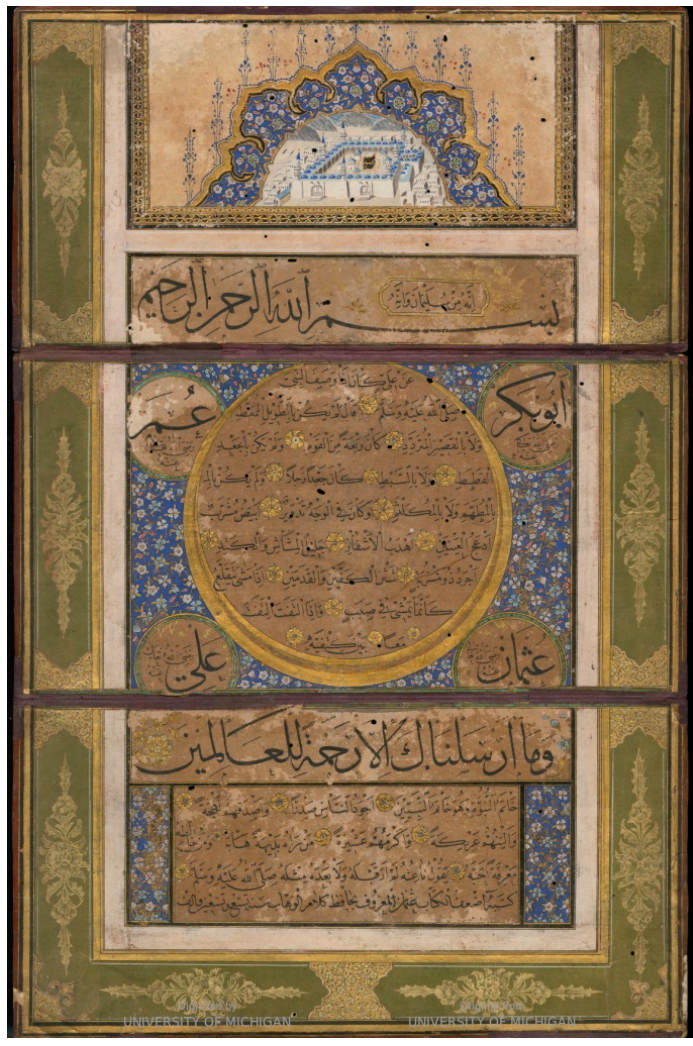
Figure 10. This Ḥ ā fiz ‘Osm ā n ḥ ilye received in the mid-eighteenth century an illumined headpiece with an image of Mecca, and, at some point in the nineteenth, the green-and-gold border; signs of considerable use and display and ensuing re-mountings are evident across the piece. Ann Arbor, University of Michigan, Special Collections Library, Isl. Ms. 238.